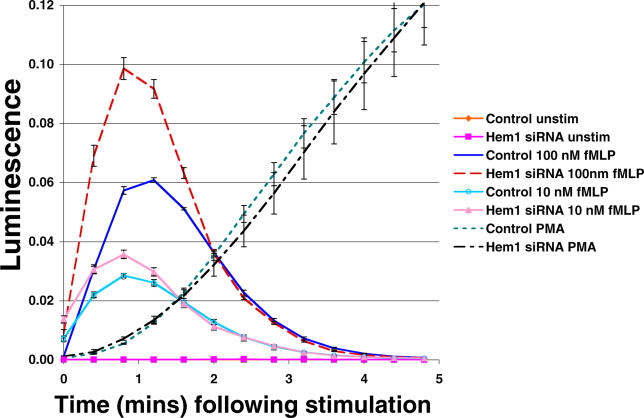
Hem-1 Knockdown Does Not Inhibit Reactive Oxygen Production in Response to ChemoattractantThe 6- to 7-day differentiated HL-60 cells were stimulated with the indicated concentration of fMLP or PMA, and reactive oxygen production was monitored in a luminometer. (Control unstimulated cells are superimposable with Hem-1 siRNA unstimulated cells.) Results are shown with standard error for cells stimulated in triplicate at 37 °C.